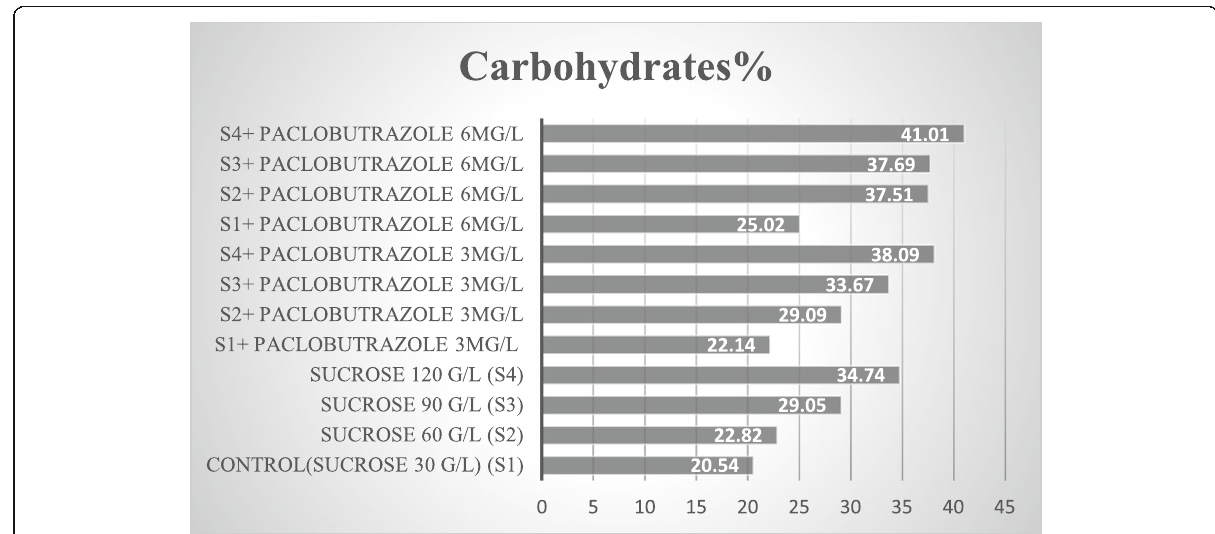
Fig. 6 Carbohydrates percent in Lilium bulblets with studied concentrations of sucrose and